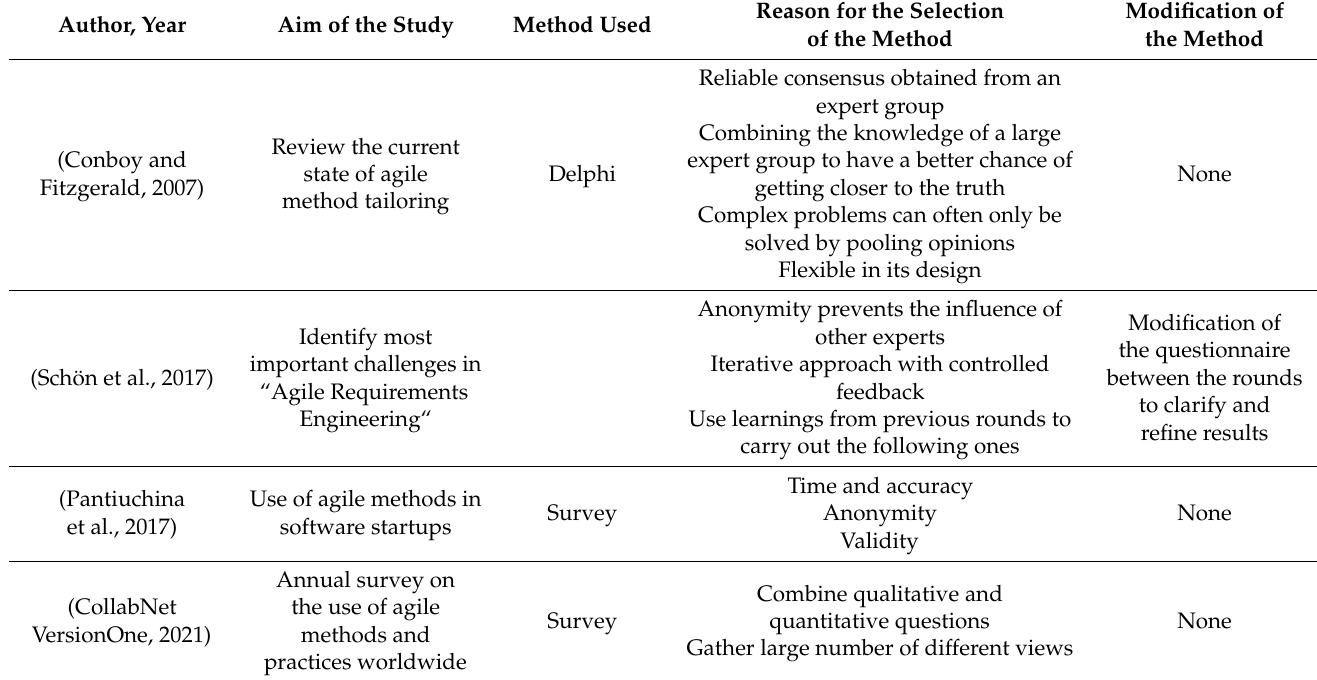
Table 2. Overview of Delphi studies and surveys in the field of agile methods